Question: State the chart type depicted above.
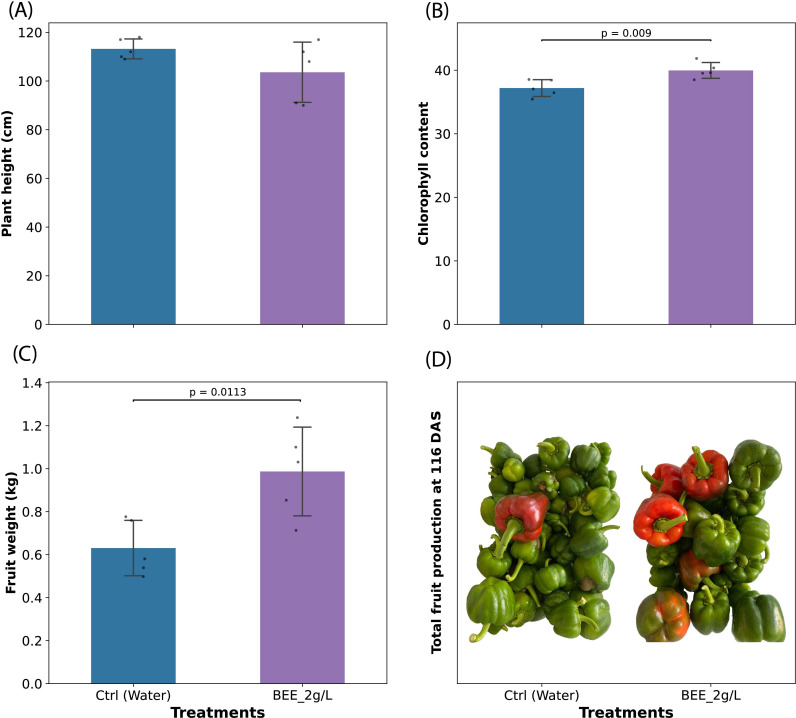
Answer: bar